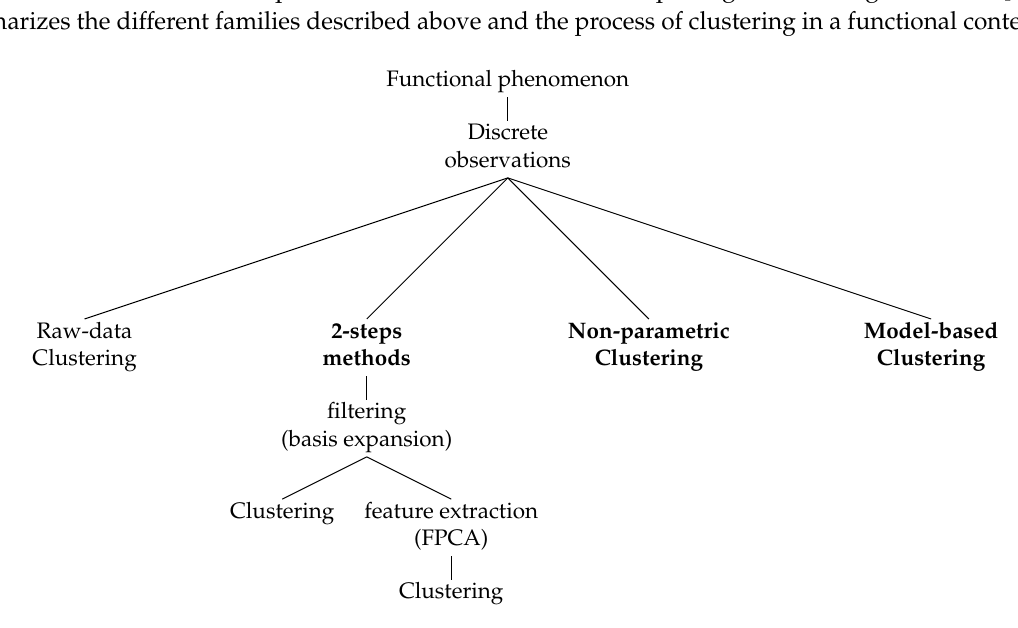
Figure 1. Summary of the different approaches to perform clustering on functional data, from raw data ( top ) to final clusters ( bottom